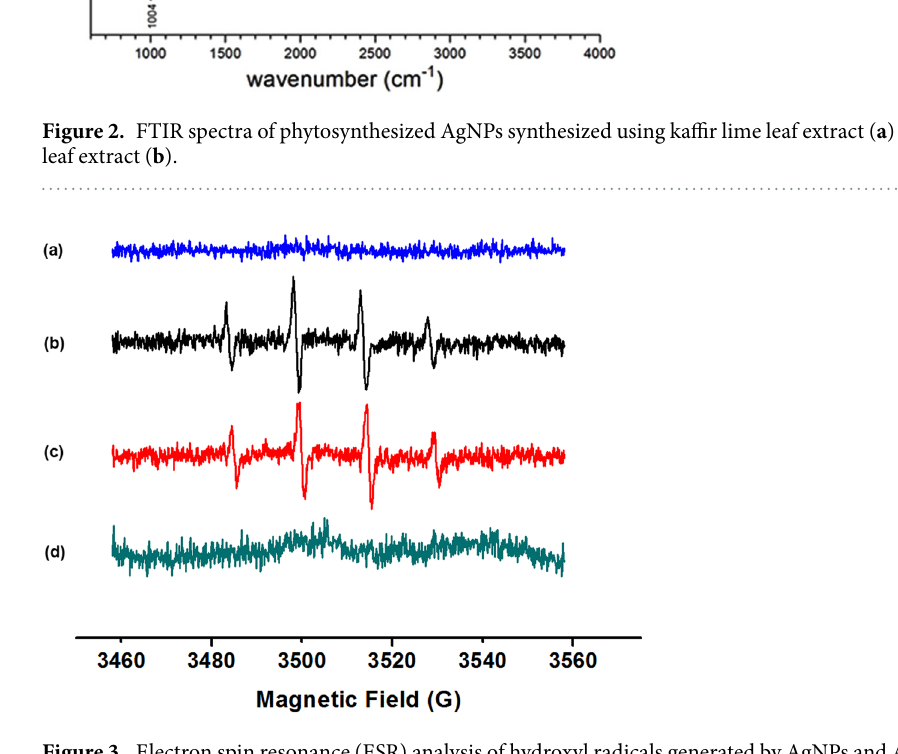
Figure 3. Electron spin resonance (ESR) analysis of hydroxyl radicals generated by AgNPs and AgNO 3 . ESR spectra of ( a ) control sample containing 50 mM DMPO + 0.5 mM H 2 O 2 + 10 mM pH 3.6 HAc-NaAc in the absence of AgNPs or AgNPs, ( b ) standard Fenton reaction (50 mM DMPO + 0.5 mM H 2 O 2 + 2.5 mM FeSO 4 ), ( c ) sample containing 50 mM DMPO + 0.5 mM H 2 O 2 + 10 mM pH 3.6 HAc-NaAc in the presence of 10 mg L − 1 AgNPs, and ( d ) sample containing 50 mM DMPO + 0.5 mM H 2 O 2 + 10 mM pH 3.6 HAc-NaAc in the presence of 10 mg L − 1 AgNO 3